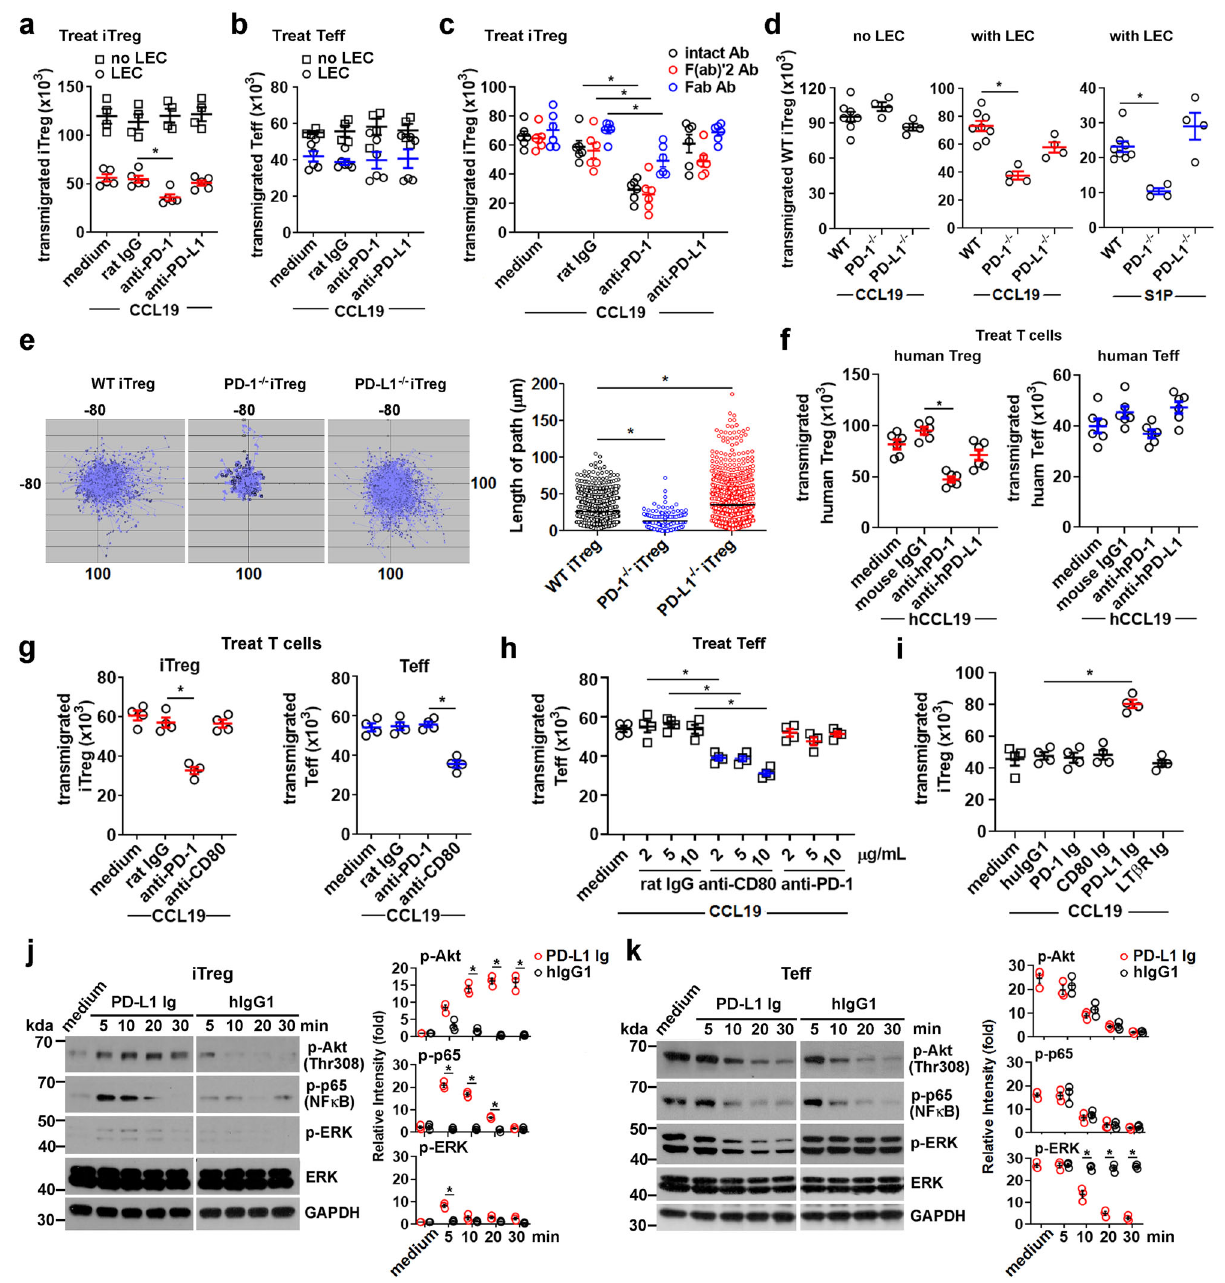
Fig. 2 Essential roles of PD-1 and CD80 for T cell TEM. a In vitro migration assay of iTregs treated with anti-mouse PD-1 (Rmp1-14), anti-mouse PD-L1 (10 F.9G2), or rat IgG (2A3), loaded in Boyden chambers with or without LEC. b Same as in a , in vitro migration of blocking mAb-treated Teffs. c Comparison of blocking intact mAb (2 μ g/mL) and F(ab) ’ 2 mAb (1 μ g/mL) treatment of iTregs for TEM. d WT, PD-1-de fi cient (PD-1 − / − ), and PD-L1- de fi cient (PD-L1 − / − ) iTregs TEM. e Time-lapse imaging of WT, PD-1 − / − , PD-L1 − / − iTreg movements during TEM. f In vitro migration of human Tregs or Teffs blocked with 5 μ g/mL anti-human PD-1 (EH12.2H7), anti-human PD-L1 (29E.2A3), or mouse IgG1. g iTregs as in a or Teffs as in b treated with 2 μ g/mL anti-mouse PD-1 (Rmp1-14), anti-mouse CD80 (1G1), or rat IgG (2A3). h Teffs as in b treat with various doses of anti-CD80 (1G1) or anti-PD-1 (Rmp1-14). i iTregs as in a loaded in Boyden chambers coated with 1 μ g/mL mouse PD-L1 Ig, CD80 Ig, LT β R Ig, or mouse IgG1. j , k Immunoblotting for Akt, NF κ B-p65, and ERK phosphorylation after PD-L1 ligation of iTregs ( j ) and Teffs ( k ) stimulated for the indicated times with 1 μ g/mL mouse PD-L1 Ig, CD80 Ig, or IgG1 coated on wells. Relative band intensities shown. Data representative of 3 independent experiments ( a – k ). Mean ± SEM. * p < 0.01 by one-way ANOVA with Sidak ’ s multiple comparisons test in the same group ( a – d , f – i ), p <0.0001 by unpaired t -test ( e ), or p < 0.001 by unpaired, two-tailed t -test with Welch ’ s correction ( j , k ). Source data are provided as a Source Data fi